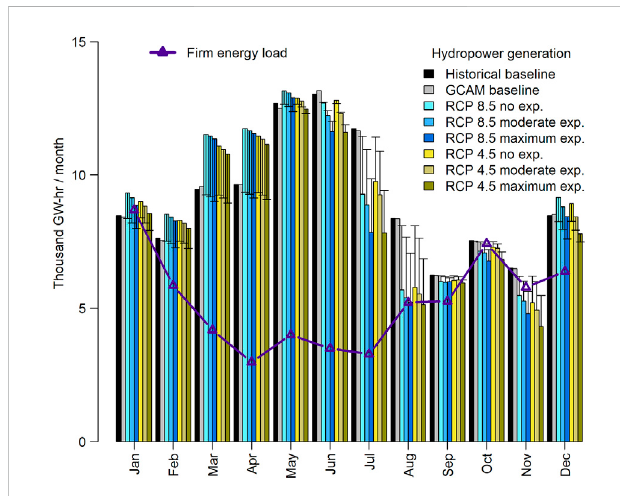
FIGURE 9 Hydropower generation at major hydroelectric dams in the CRB compared to the fi rm energy load. Mean monthly generation was calculated over 1986 – 2015 (baseline scenarios) or 2046 – 2075 (future scenarios). The black horizontal line within (or above) each column represents the hydropower generation for that scenario run with historical GridMet/Livneh climate